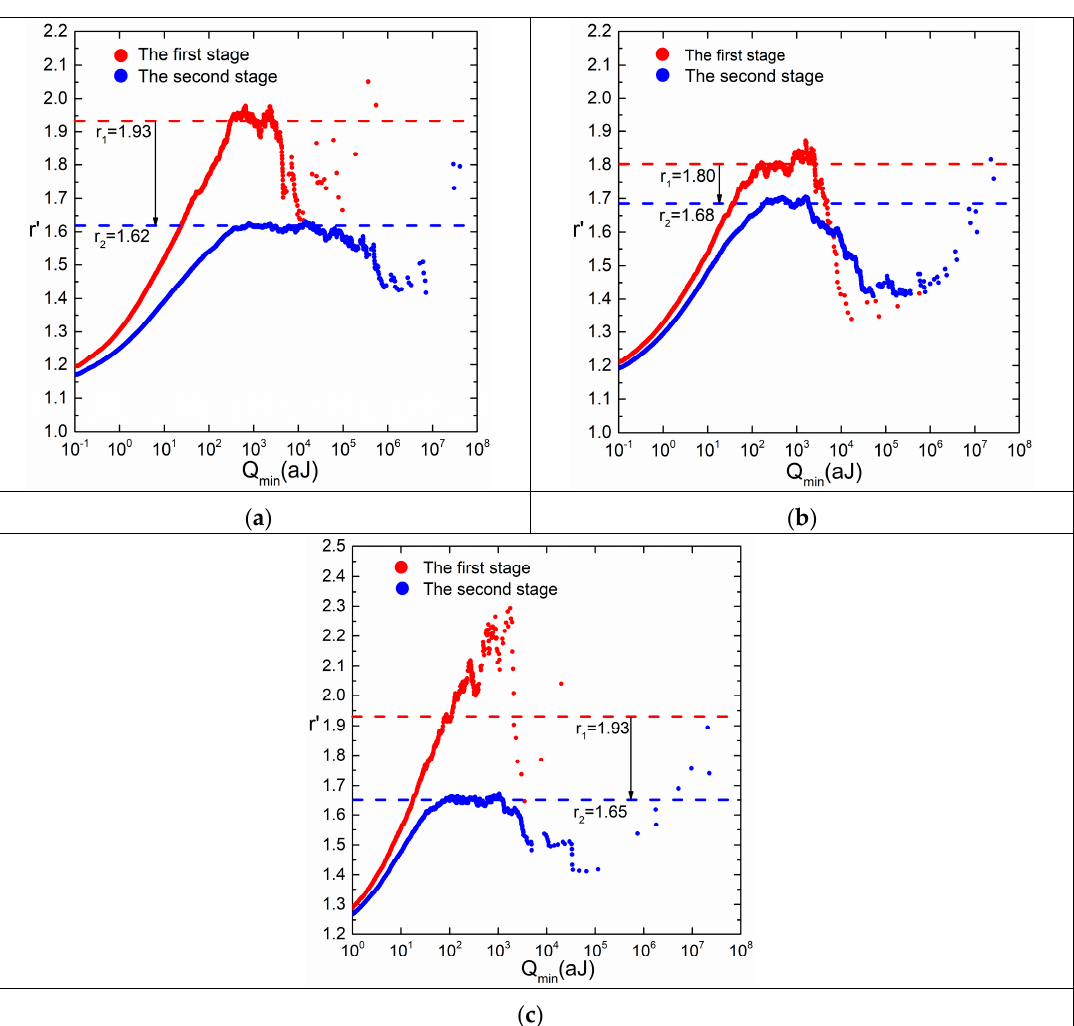
Figure 9. Fitted exponent r